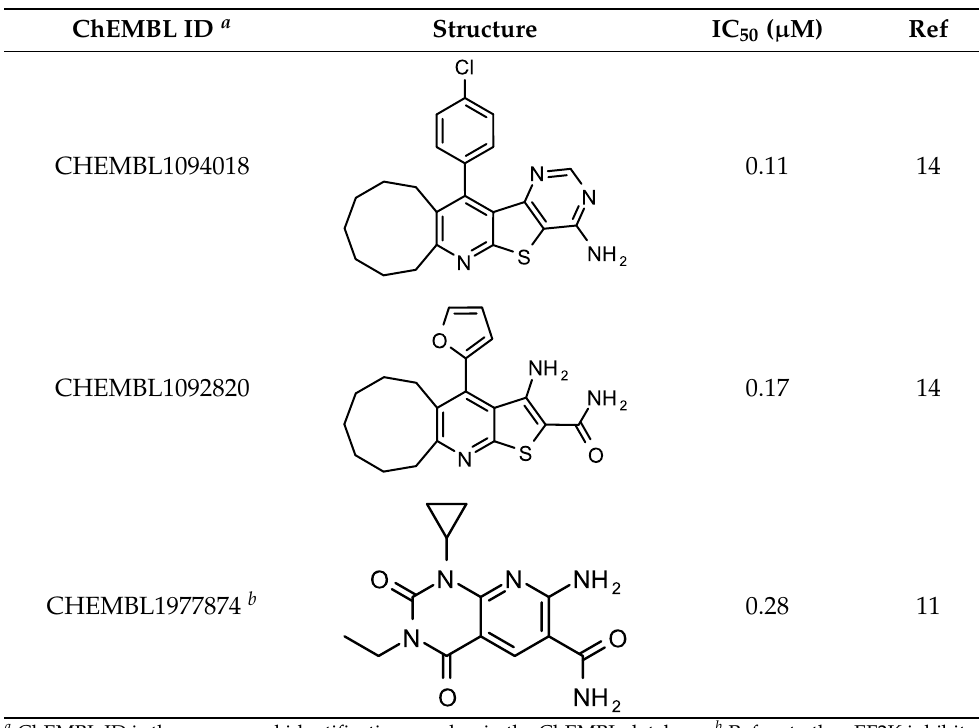
Figure 2. Overview of virtual screening using CGBSP. Table 1. Representative eEF2K inhibitors with the corresponding IC 50 values obtained from rele- vant